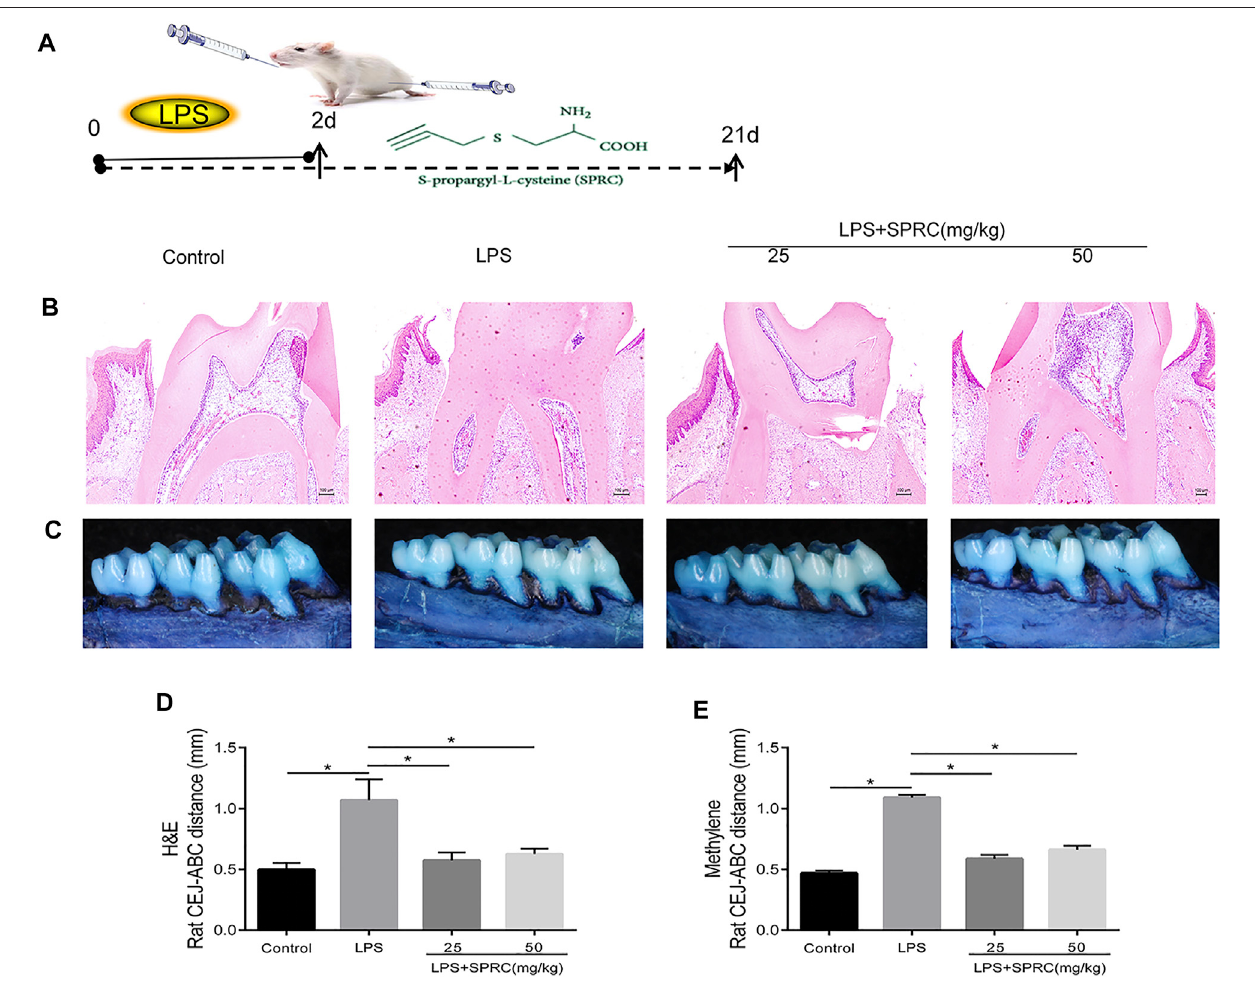
FIGURE 1 | Effect of SPRC on bone resorption. The crest height between the (CEJ) and the alveolar bone crest (ABC). (A) Schema chart (B) H&E staining of bone resorptionofmaxillasections( × 200magni fi cationscalebar (cid:1) 100 μ m) (C) Methylenestainingofboneresorptionofleftmaxilla, (D) H&Estainingdataquantitativeanalysis (E) Methylene staining data quantitative analysis. Speci fi cally, measurements were performed on the fi rst molars (at 3 sites), second molars (at 2 sites), and third molars (at 1 sites), red line indicate CEJ-ABC distance (Data are shown as the means ± SD from eight animals * p < 0.05 vs. LPS group).